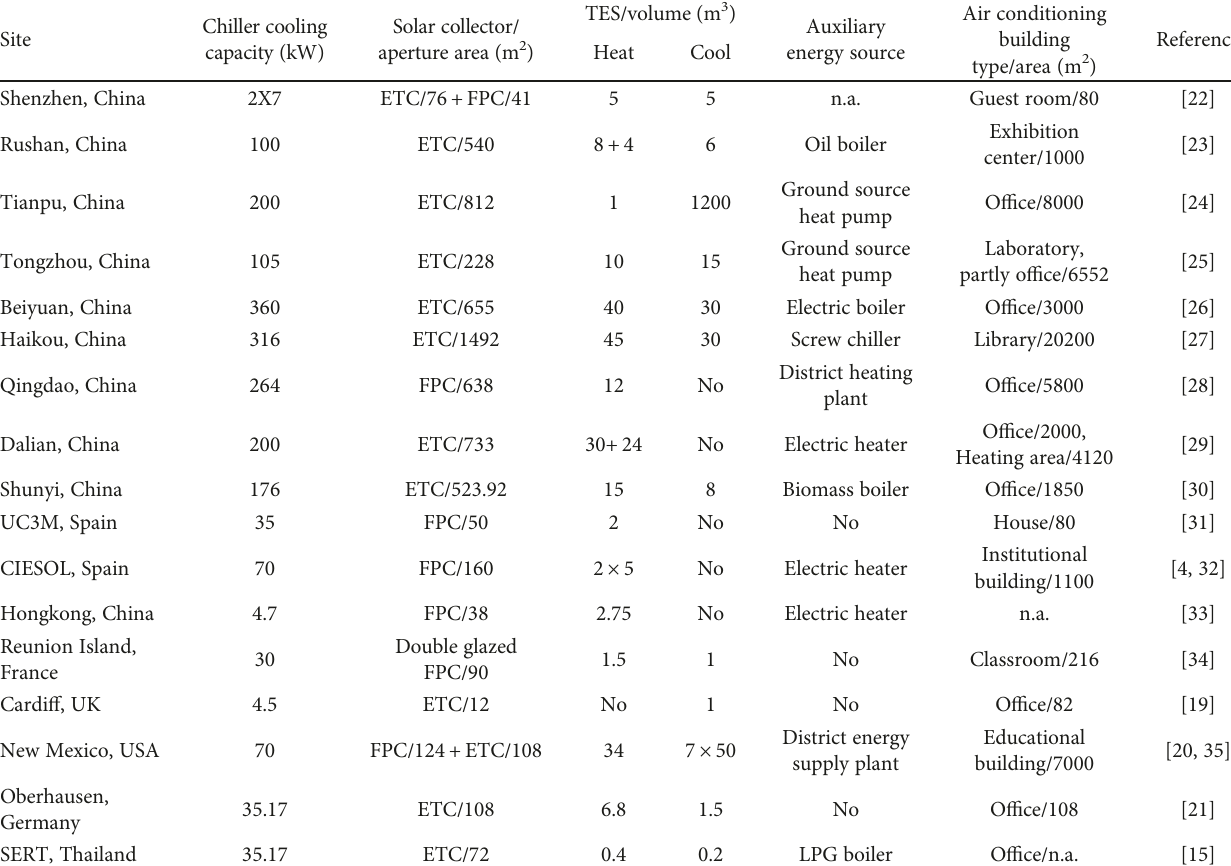
Table 1: Characteristics of some conventional SHCSs equipped with a single-e ff ect absorption chiller.